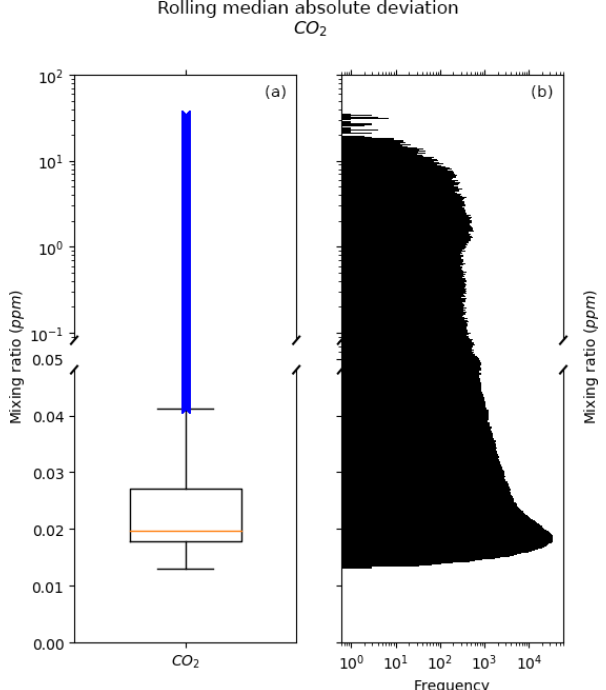
Figure A8. As in Fig. A6 but for CO 2 mixing